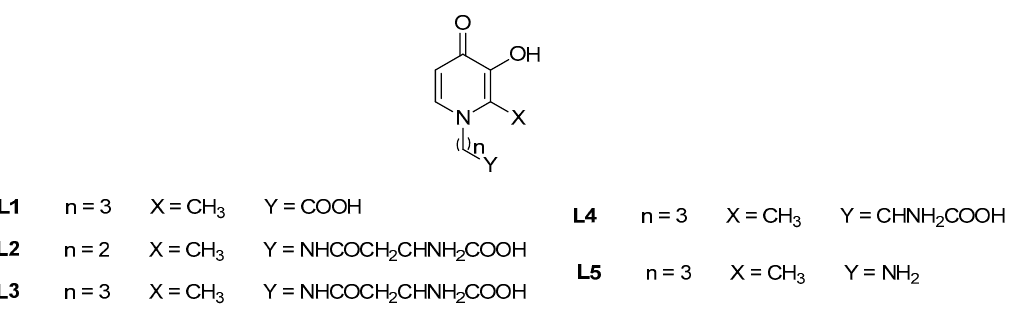
Figure 2. Mono-hydroxypyridinone ligands employed for thermodynamic studies on metal chelation.